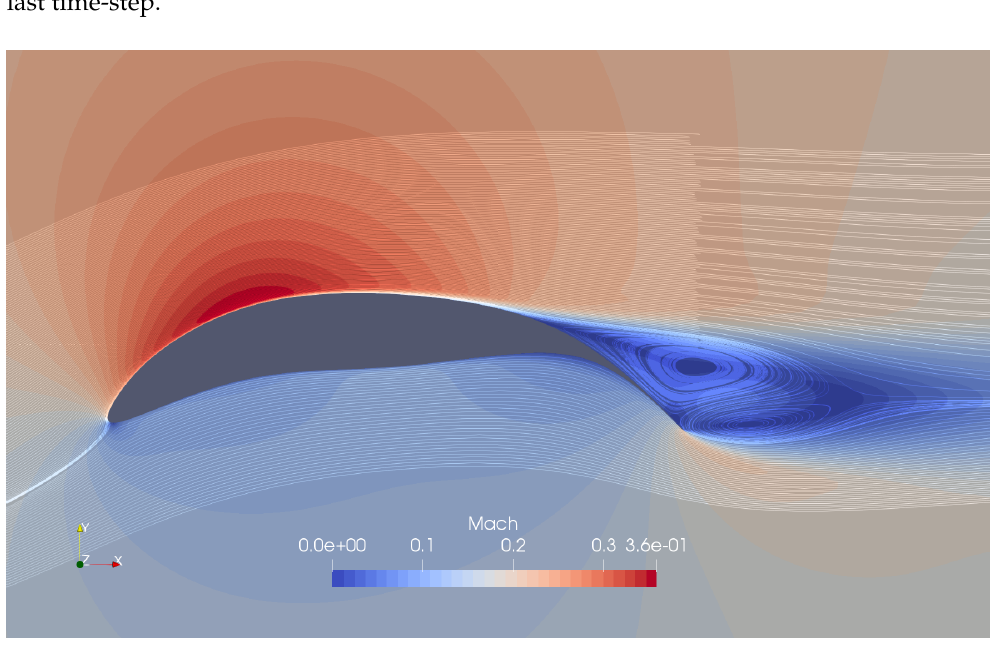
Figure 15. Flow visualisation on the definitive morphed airfoil for M ∞ = 0.185 and α = 10.1 ◦